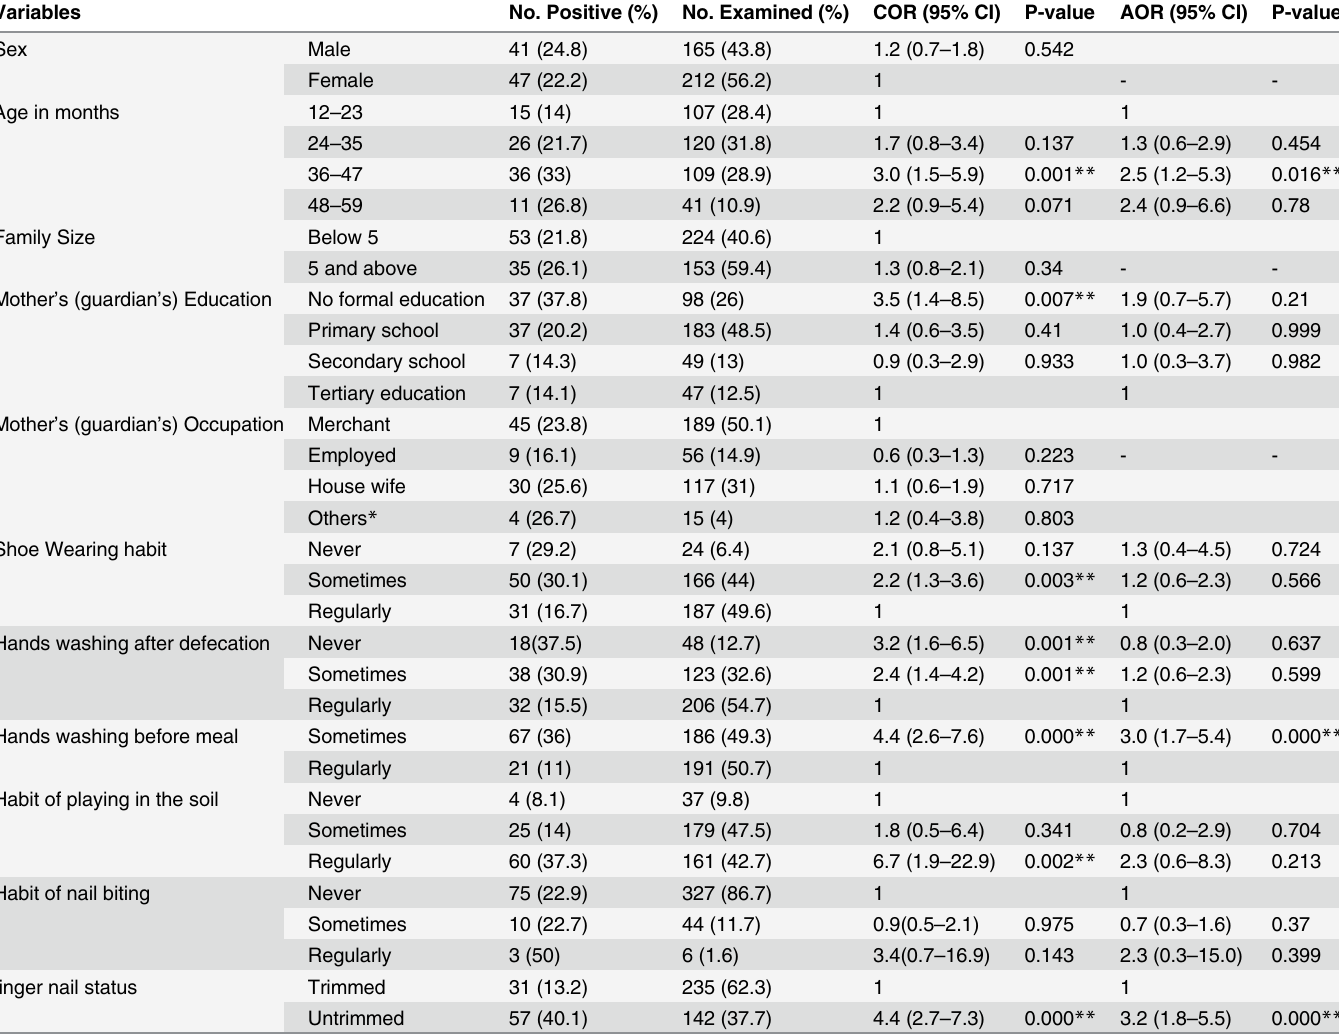
Table 3. Factors associated with soil-transmitted helminths infection among the preschool aged children, Butajira, south-central Ethiopia, 2014. Variables Sex